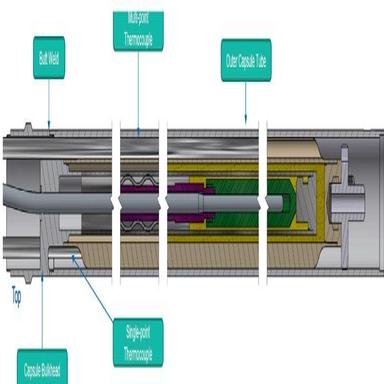
Shows a cross-section view of the IMPACT outer capsule assembly.